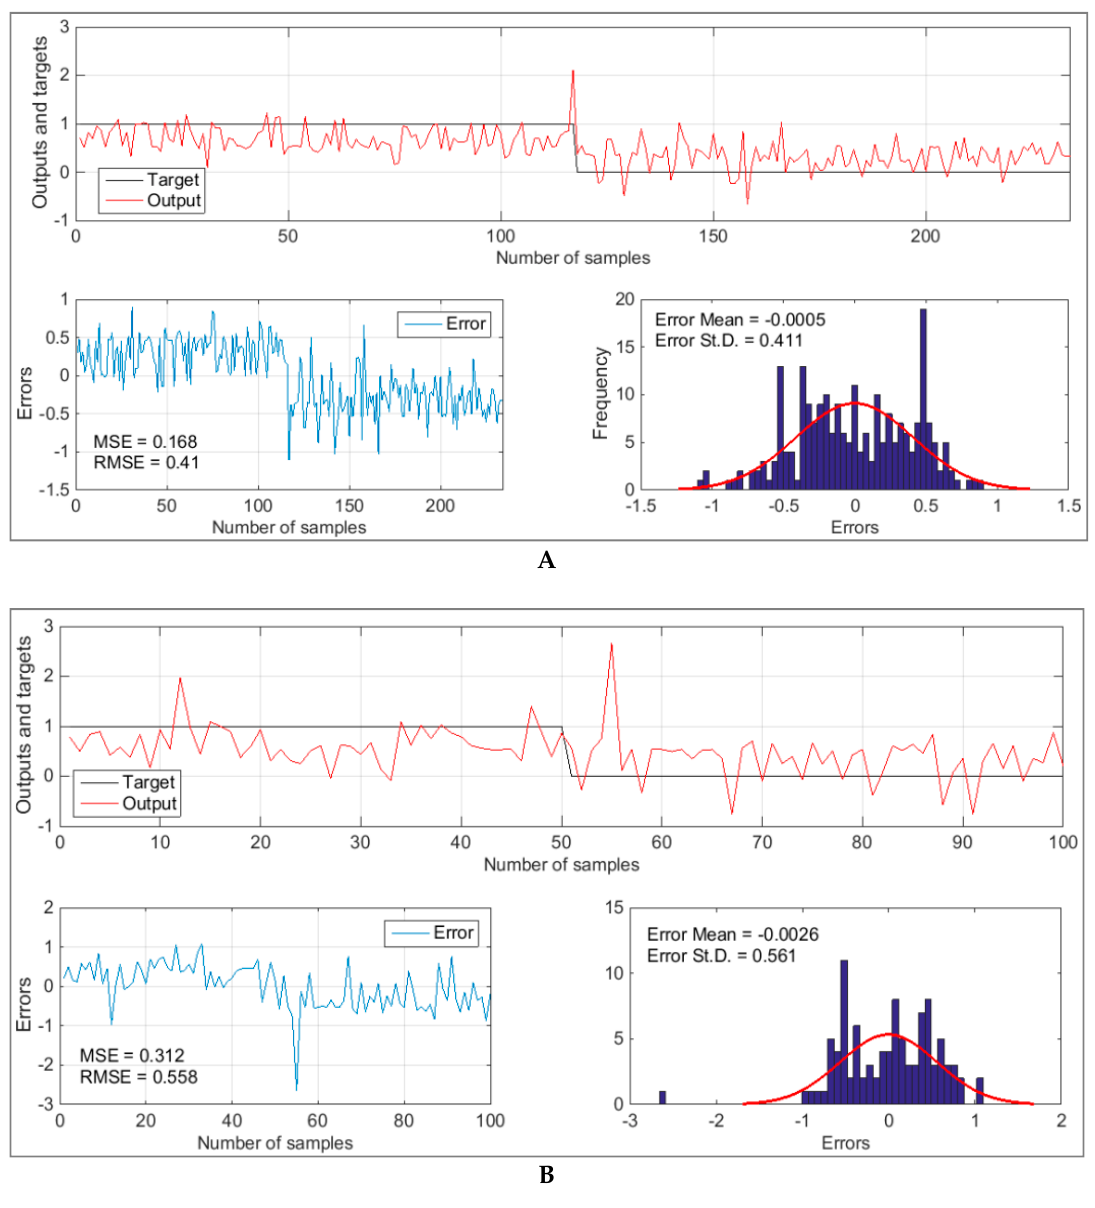
Figure 9. Analysis of errors of the PSOANN model using ( A ) the training dataset and ( B ) the validating dataset.